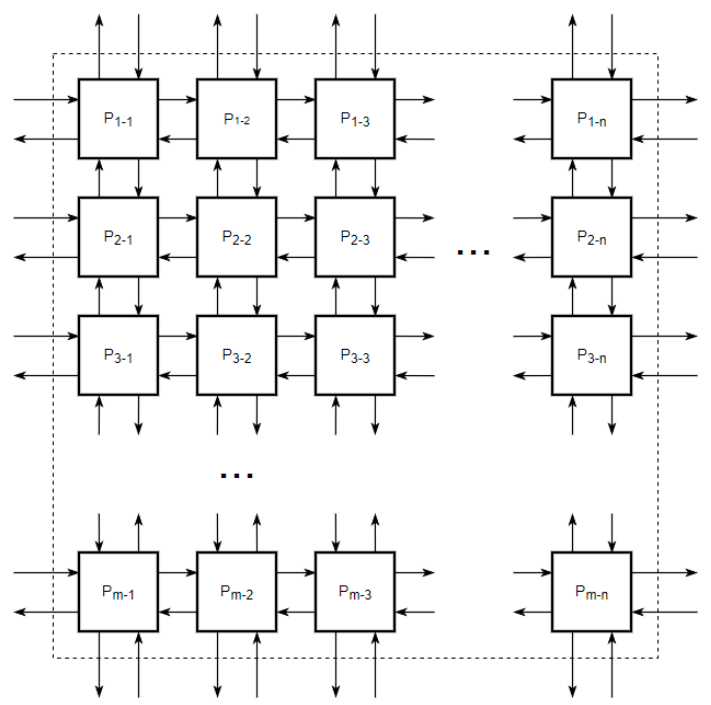
Figure 3. Reconfigurable computing